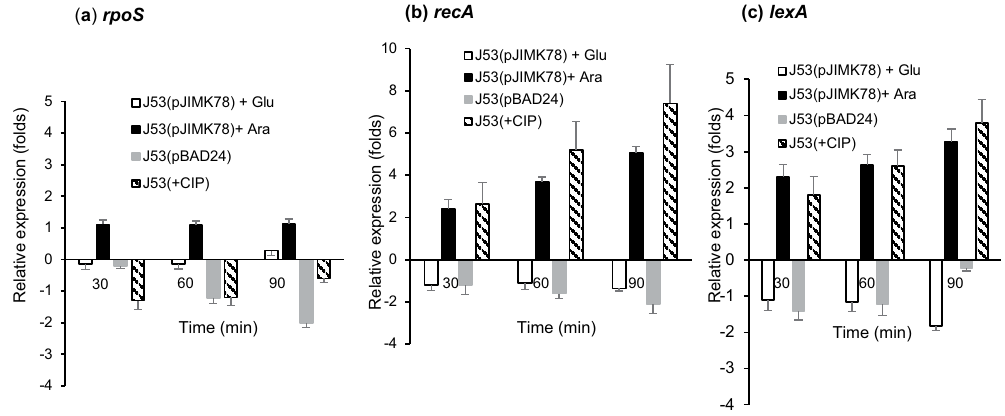
Figure 4. Relative expression of stress response genes rpoS ( a ), recA ( b ) and lexA ( c ), in the presence of ParE I toxin induction or repression in E. coli J53(pJIMK78). Toxin-induced state (with 0.2% arabinose) ( ■ ), toxin- repressed state (with 0.2% glucose) ( □ ) is compared with CIP-treated (0.25 µ g/mL) cells ( ) and J53(pBAD24) vector-only control cells ( ). Each experiment was repeated three times, and the mean values with standard deviations (error bars) are